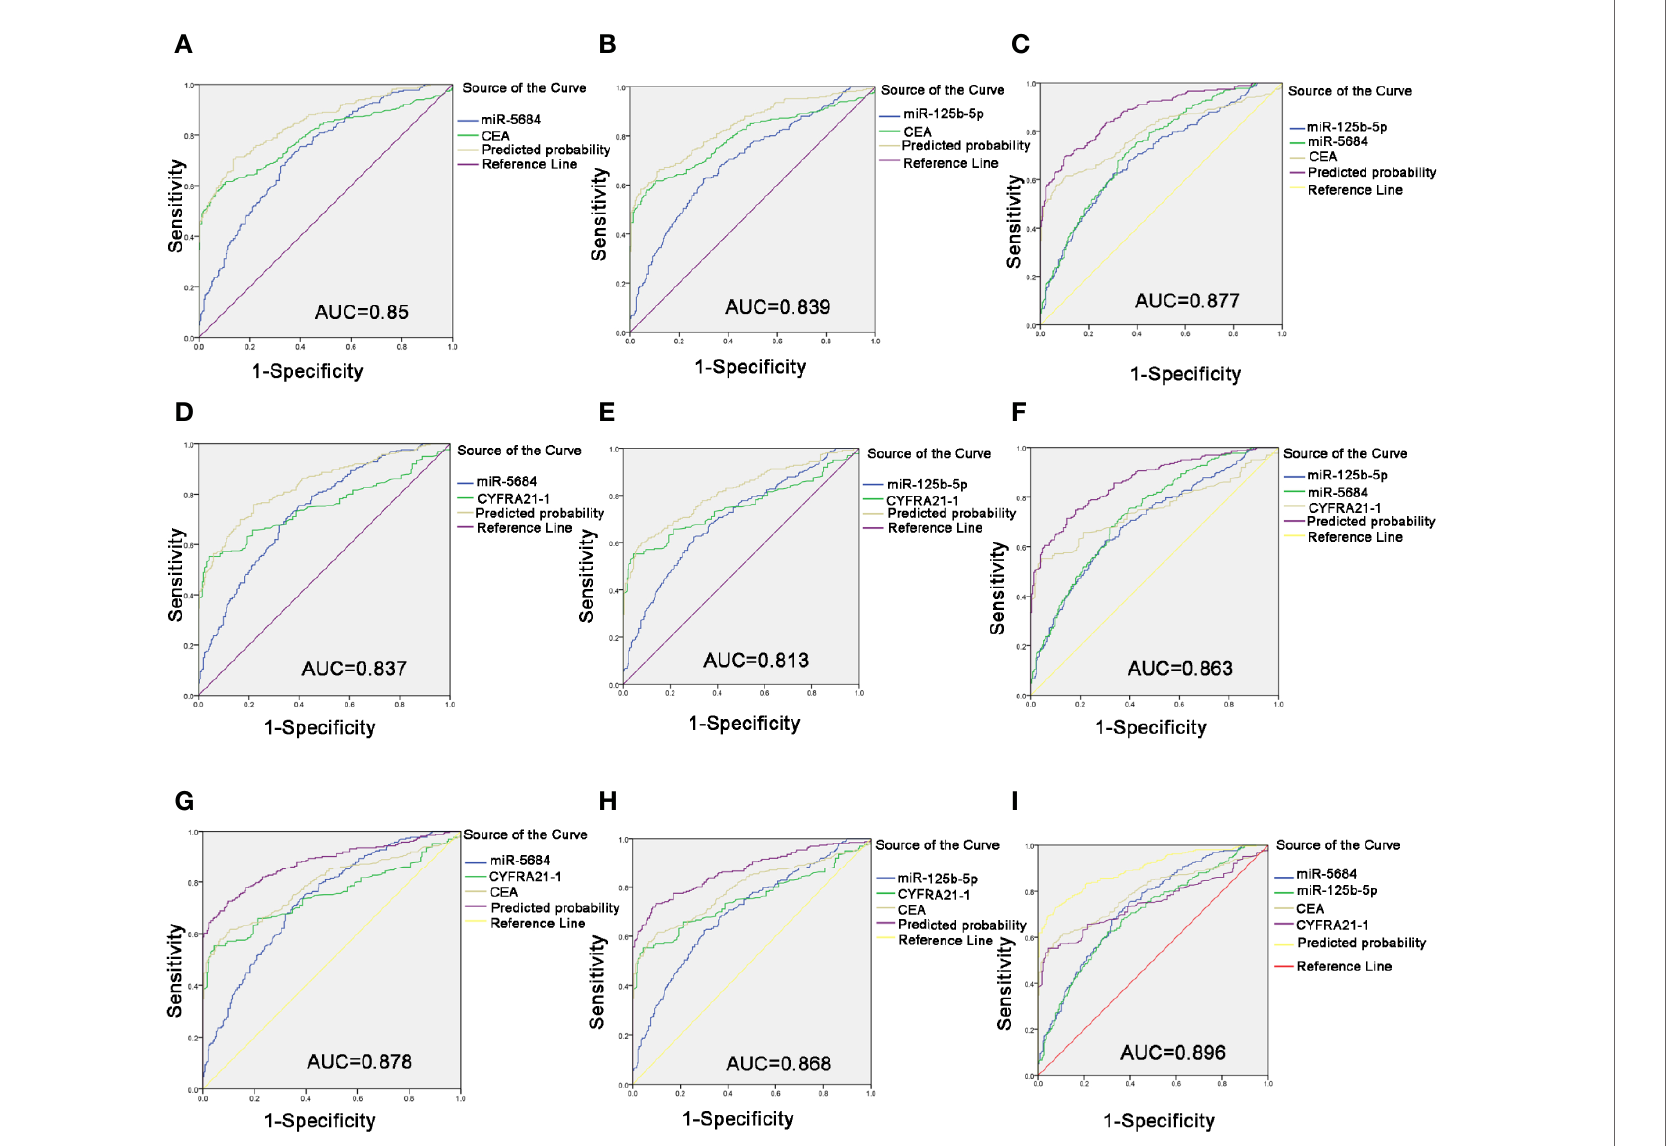
FIGURE 6 | Improved diagnostic capacity of serum exosomal miRNAs combined with established tumor markers in NSCLC patients. The AUCs of CEA combined with miR-5684 (A) , miR-125b-5p (B) , and both (C) . The AUCs of CYFRA21-1 combined with miR-5684 (D) , miR-125b-5p (E) , and both (F) . The AUCs of CEA and CYFRA21-1 combined with miR-5684 (G) , miR-125b-5p (H) , and both (I)